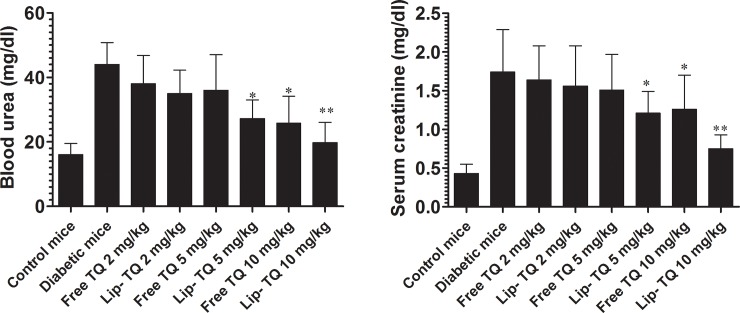
Treatment with Lip-TQ improves the functioning of the kidneys in C. albicans infected diabetic mice.On day 4th post treatment, the blood was drawn from the mice of various groups to measure the levels of (A) blood urea, (B) serum creatinine. Data are expressed as mean ± SD. A P value <0.05 was considered to be significant.